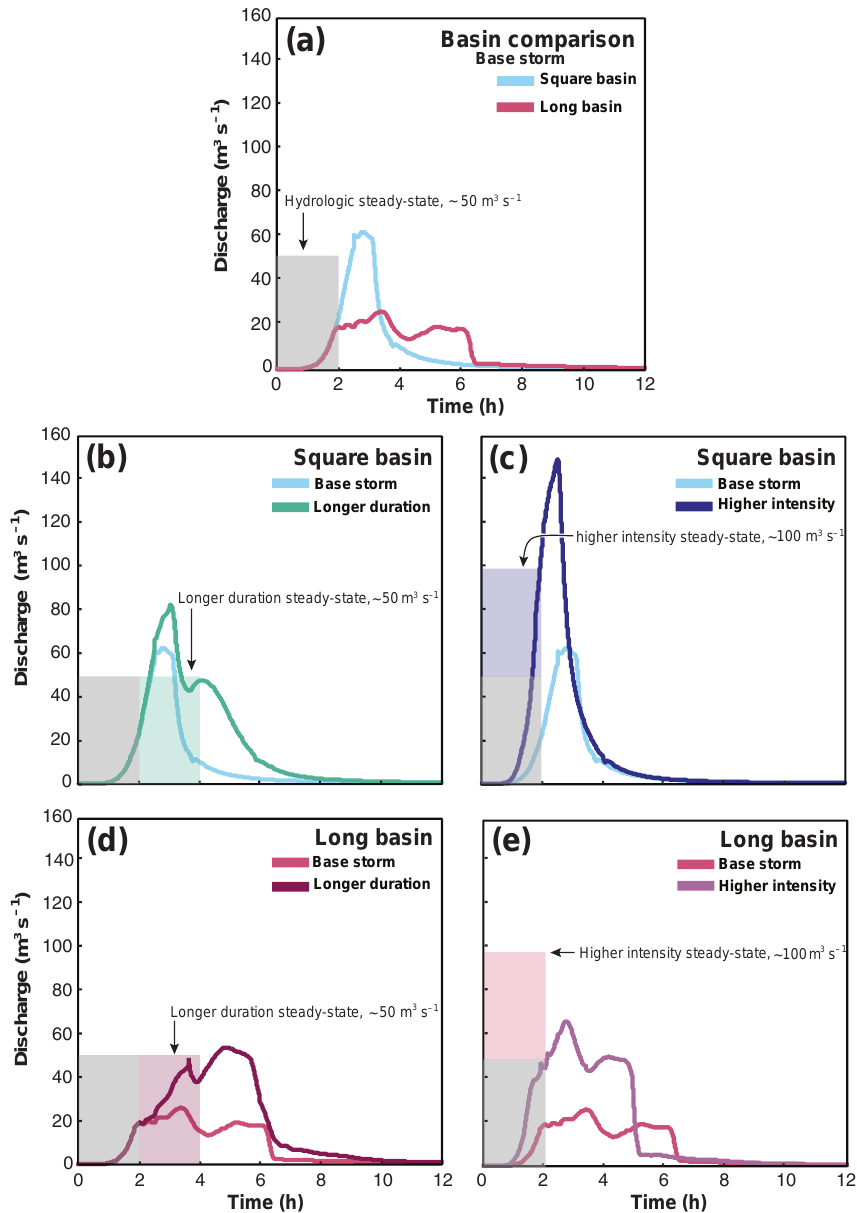
Figure 10. OverlandFlow output for all storms described in Table 4. Hydrographs are taken from the active link upstream of the outlet node. Steady-state discharge is shown for each event, with the gray box representing the base storm in all cases. Panel (a) shows the base storm for both the square basin and the long basin; panel (b) compares outlet hydrographs from the base and longer duration storms in the square basin; panel (c) compares outlet hydrographs from the base and higher intensity storms in the square basin; panel (d) compares outlet hydrographs from the base and longer duration storms in the long basin; panel (e) compares outlet hydrographs from the base and higher intensity storms in the long